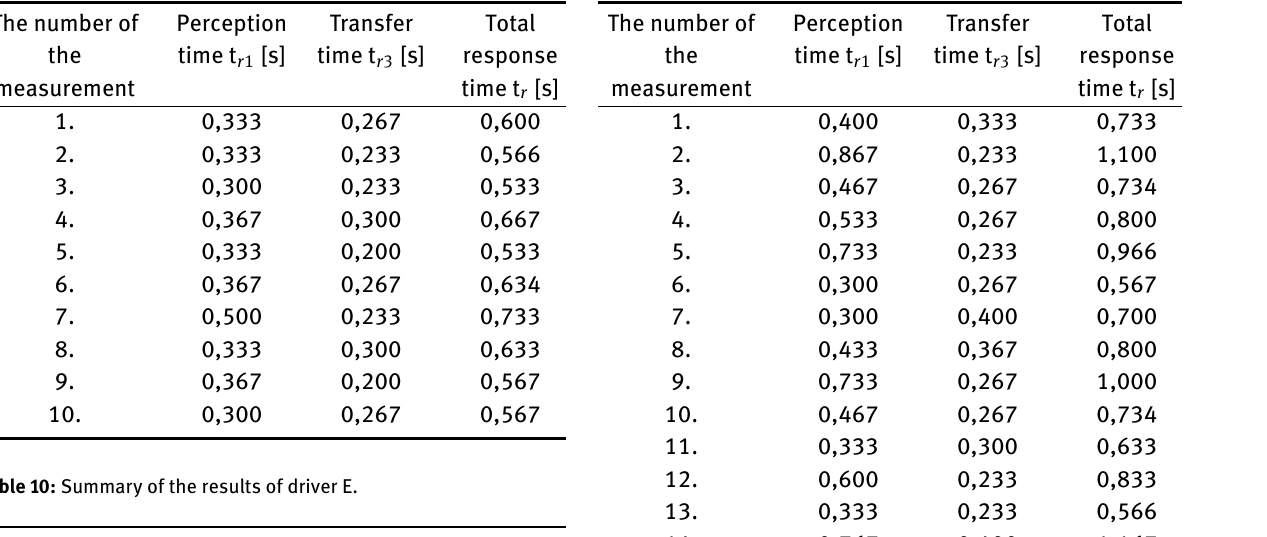
Table 11: Summary of the results of driver F.